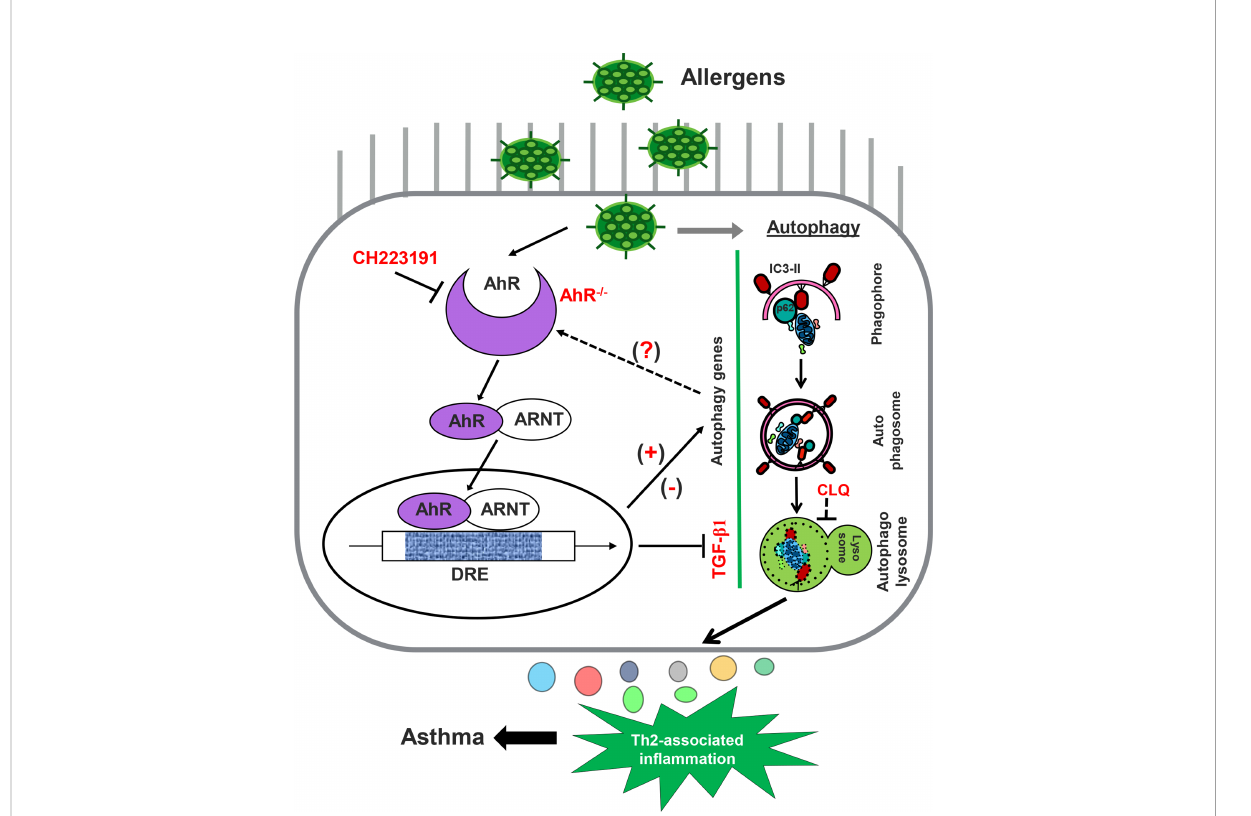
FIGURE 9 Graphic summary. AhR in AT2 cells regulates cockroach allergen – induced autophagy. Cockroach allergen can induce autophagy that is critical in controlling proin fl ammatory mediator release, Th2-associated airway in fl ammation, and, subsequently, allergic asthma. AhR in AT2 cells inhibits cockroach allergen – induced autophagy through either controlling TGF- b 1 release or AhR-regulated autophagy-associated genes [either upregulated (e.g., CALCOCO2 ) or downregulated (e.g., S100a9